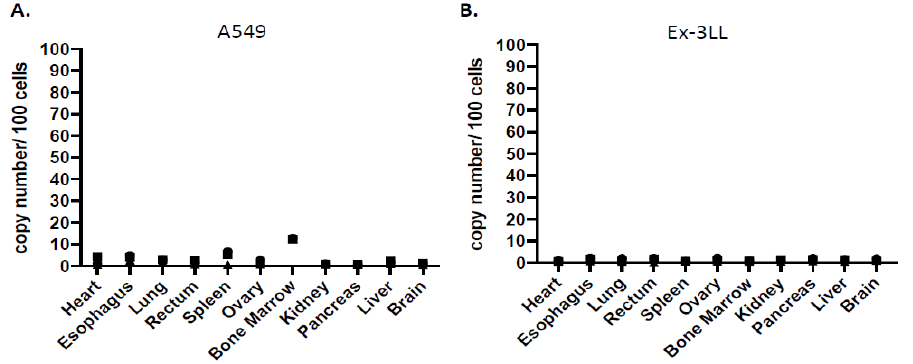
Figure 5. Systemic biodistribution of Toca 511 in subcutaneous lung cancer models. Genomic DNA was extracted from various tissues ( n = 3 per tissue) after Toca 511/5-FC-treatment in ( A ) immunode- ficient A549 human lung cancer xenograft models and ( B ) immunocompetent Ex-3LL murine lung cancer models. Integrated RRV sequences were quantitated by qPCR based on reference curve values and expressed as vector copy numbers per 100 cell genome equivalents of DNA. The logarithmic graph was shown in Supplementary Figure